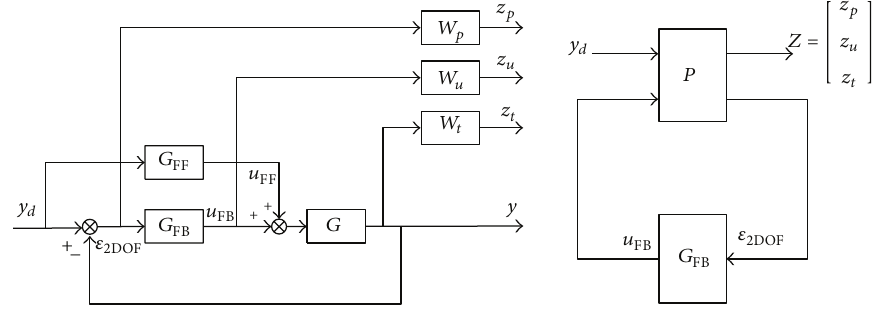
Figure 2: 𝐻 ∞ mixed sensitivity synthesis